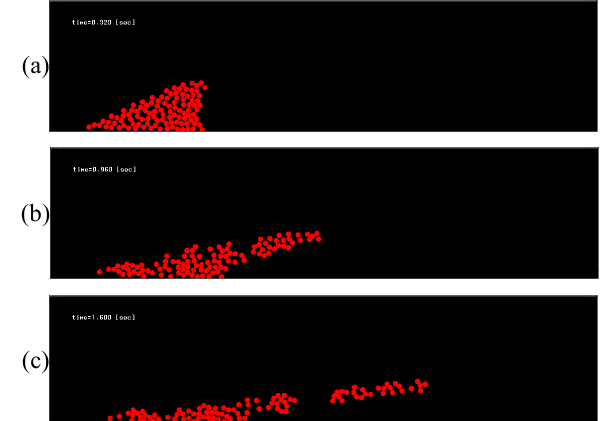
Fig. 5 The destruction process of the primary thrombus obtained from the computation for N bind = 10. (a) t = 0.32 [s]. (b) t = 0.96 [s]. (c) t = 1.60 [s]. Similarly for the case of N bind = 5, the particles separated from the original primary thrombus tend to form aggregations due to the adhesive force. The particles resisted against the fluid mechanical force to reside longer around the region of the original thrombus compared with the other cases. It resulted in shorter movement of the